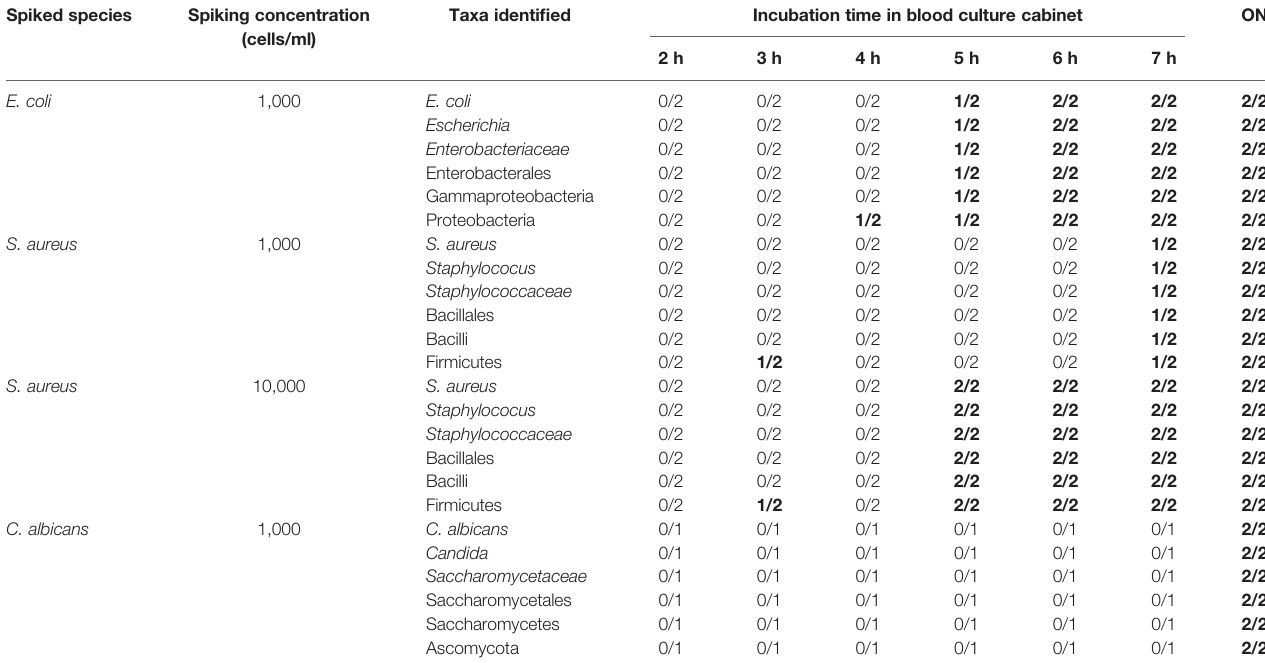
TABLE 4 | Incubation times for identi fi cations by shotgun proteotyping. Spiked species Spiking concentration